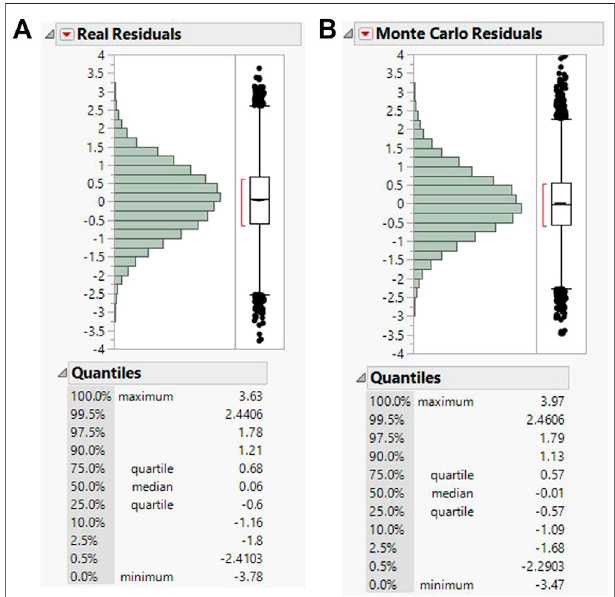
FIGURE 10 | Comparison of (A) actual N.A. residuals with (B) the N.A. residuals from MC simulation for the west girder at the controlling location (CL).